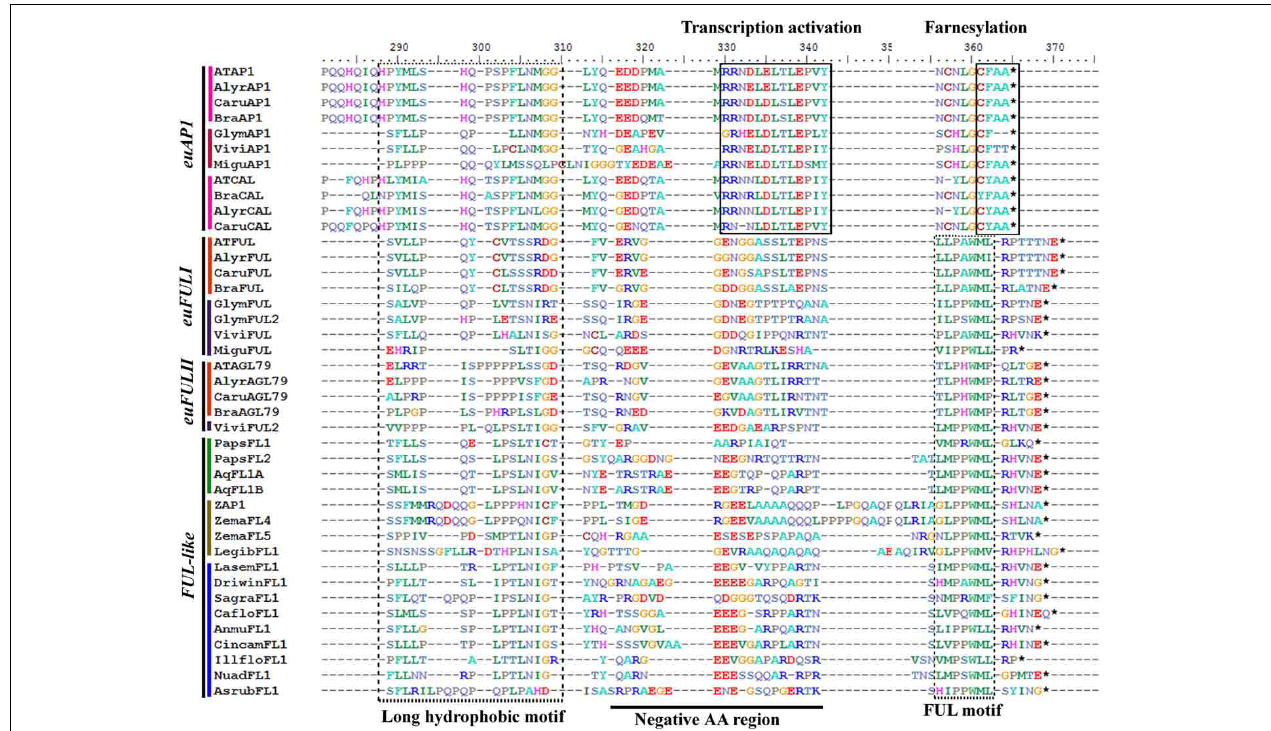
FIGURE 2 | Alignment of the end of the K and the complete C-terminal domain of APETALA1/FRUITFULL proteins (labeled with the clade names they belong to). Colors to the left of the sequences indicate the taxon they belong to as per color key in Figure 3 . The box to the left shows a conserved long hydrophobic motif, previously identified, but with unknown function, followed by a